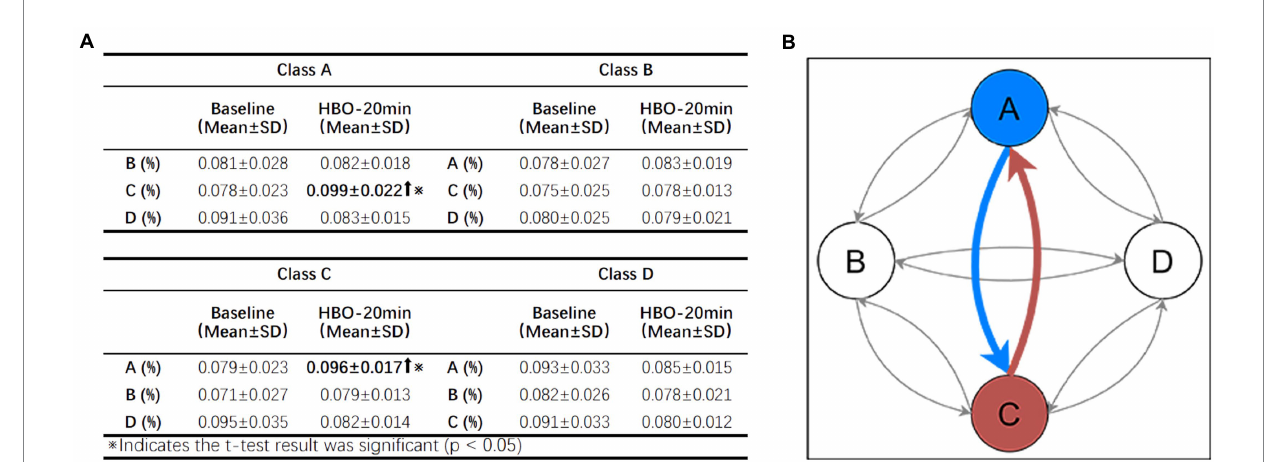
FIGURE 6 EEG microstate transition probability analysis results of DOC patients (17 cases) with CRS-R ≥ 8. (A) Analytical results of the EEG microstate transition probability in DOC patients (17 cases) with CRS-R ≥ 8. The transition probability from microstate A to microstate C and microstate C to microstate A was significantly increased after 20 min of HBO therapy compared with pretreatment ( p < 0.05). (B) Schematic diagram of the mutual transition trends among the four microstates. The 4 solid circles represent 4 microstates, and the different arrows represent the transition trends between different microstates. The gray arrows represent that the transition trends between different microstates are not significant, and the bold colored arrows represent significant transition trends ( p <